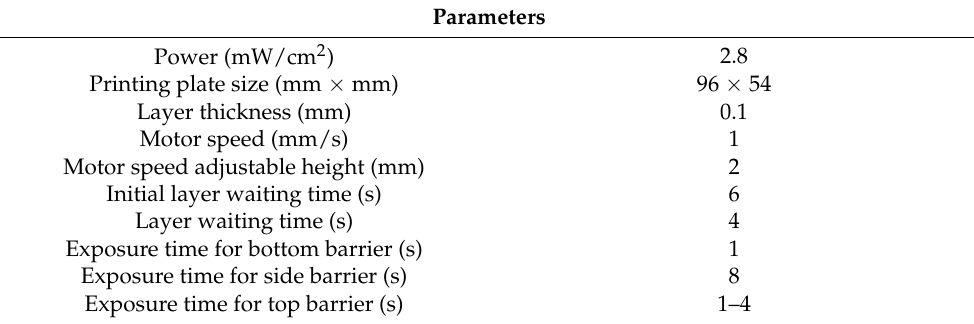
Table 1. Vat photopolymerization parameters for enclosed channel